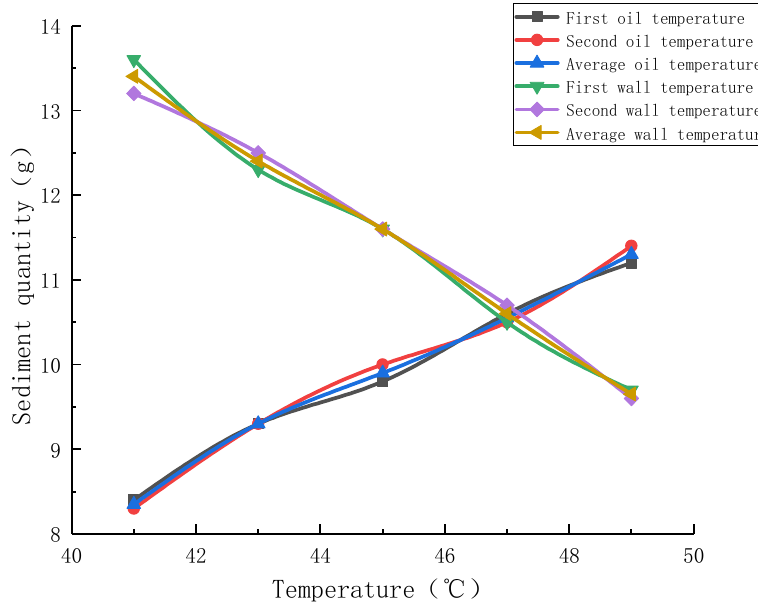
Figure 2. Sediment mass curves at the temperatures of different oils and walls.